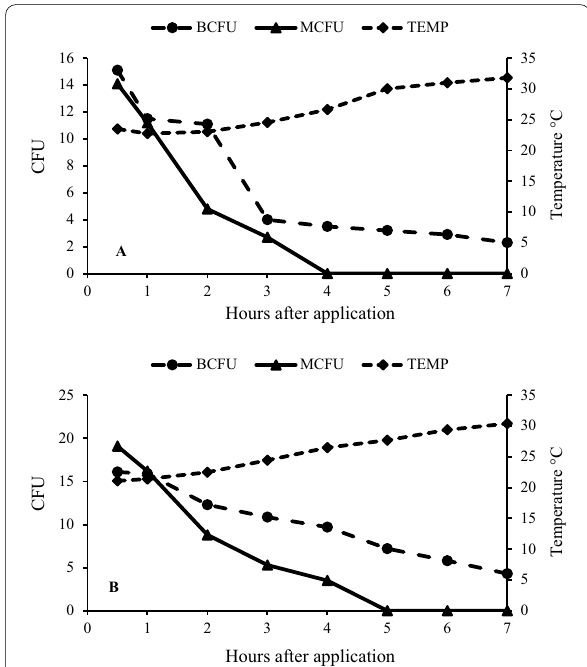
Fig. 1 Number of colony-forming units (CFUs) related to temperature at the hour of collection after fungal application. BCFU CFU of Beauveria bassiana ; MCFU CFU of Metarhizium = = A means the same lowercase letters in rows and uppercase letters in columns anisopliae . A First season of evaluation. B Second season of evaluation did not differ significantly by Tukey’s test at 5% probability